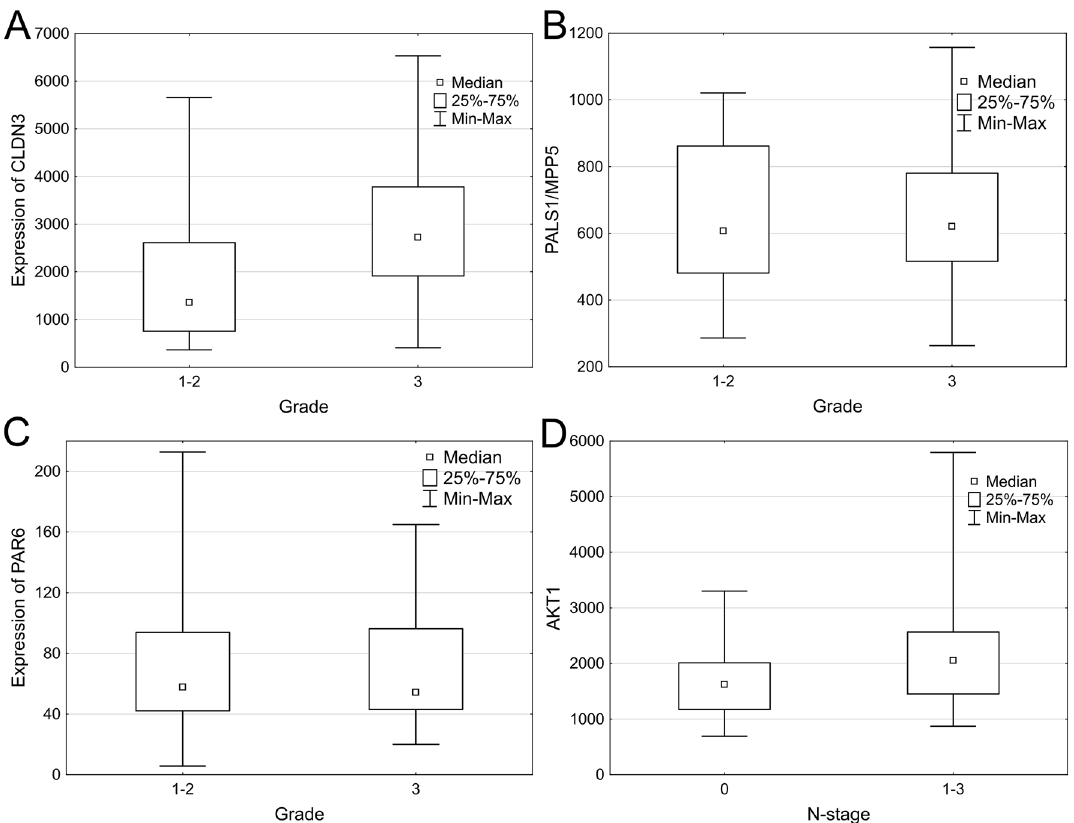
Figure 5. Association of gene expression with histological tumor grade and axillary lymph node metastasis. Expression levels of CLDN3 are associated with tumor grade (p = 0.0005) ( A ), while PALS1 and PAR6 expression are independent of tumor grade (p = 0.805 and p = 0.9 respectively) ( B , C ). High AKT1 expression levels (p = 0.033) ( D ) are associated with lymph node metastasis.